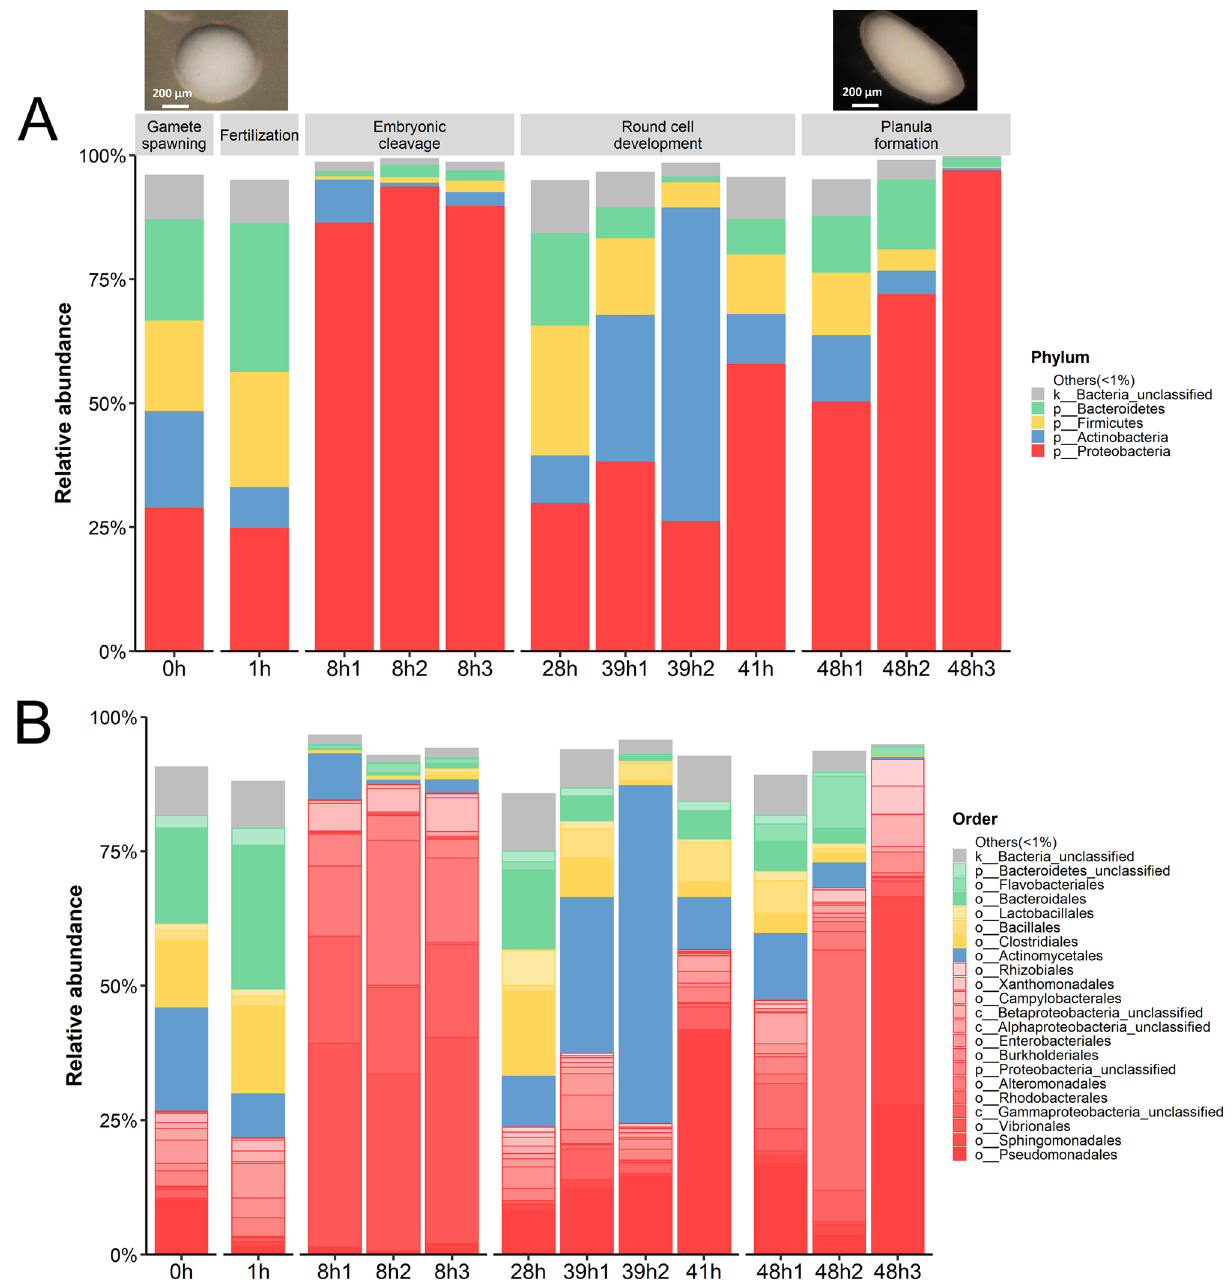
Figure 1. Relative abundance of bacterial OTU compositions during A. humilis larval development in aquaculture at ( A ) phylum and ( B ) order levels. Bacterial phyla and orders with < 1% abundance were represented in “Other (< 1%)”. In ( A ), pictures corresponding to 1 h and 48 h A. humilis larvae were